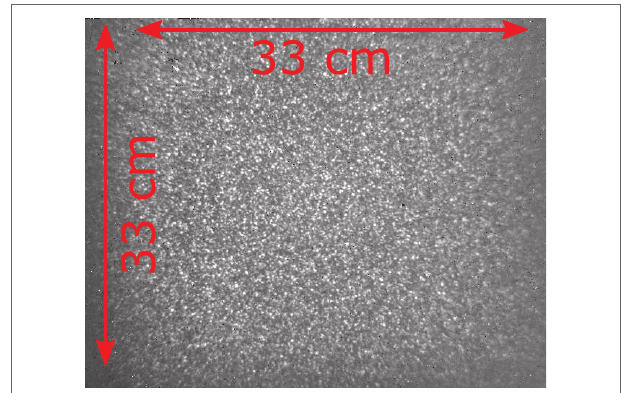
FigURe 14 | Example of the heat signature at the water surface for a calm condition without wind. This structure shows the intensity profile after the diffractive beam homogenizer (Holo/Or HH-211-A-Y-A). Small spots are visible; however, these structure smear out, once the water is pushed through this intensity distribution by the wind (c.f. Figure 5 ).